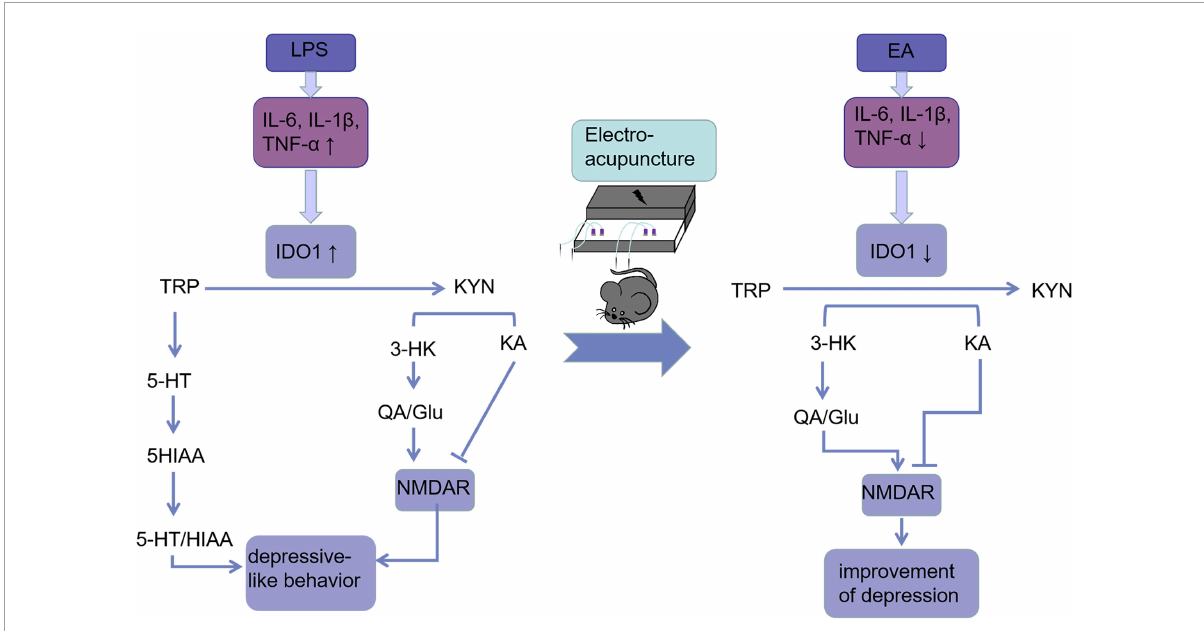
FIGURE7 Electroacupuncture linking IDO-mediated TRP mechanism pathway to behavioral changes: EA decreased circulating and cerebral pro-inflammatory cytokines after the LPS challenge, which deactivate IDO1. When IDO1 is activated, most of the TRP is metabolized into KYN, which is converted into KYNA under normal conditions. However, when IDO1 is activated, most of KYN is converted to QA, an NMDA receptor agonist that is a key factor in increasing neurotoxicity and cognitive deficits. EA ameliorated these imbalances and behavioral deficits may be through inhibiting